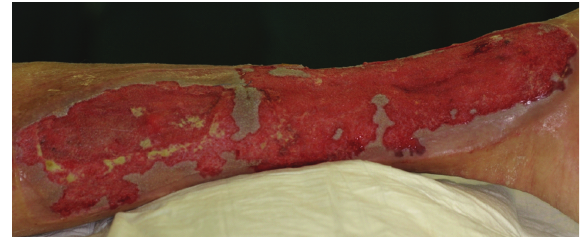
Figure 3: Appearance after 3 weeks of treatment with a vacuum dressing, intermittent suction of 75mmHg: Clean, well-granulated wound surfaces are evident, and the muscle is completely covered with granulation tissue.